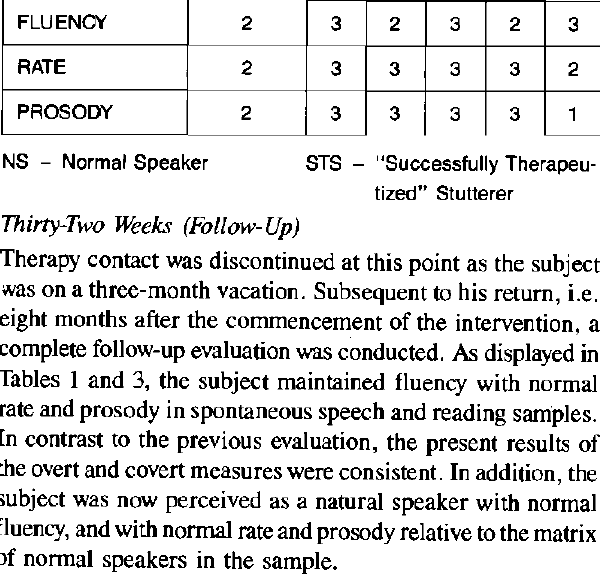
Table 3 Mean ratings of perceptual evaluation at follow-up